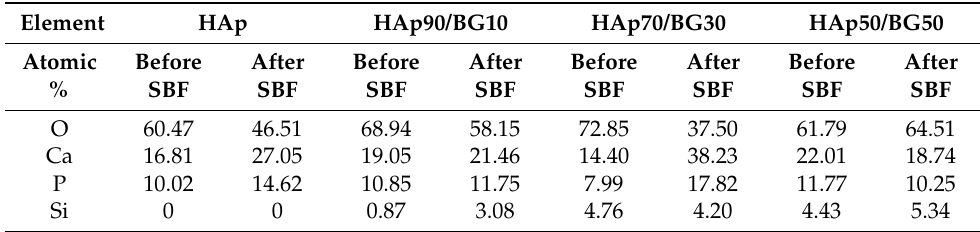
Table 6. Atomic composition of samples of HAp and HAp/BG composites before and after immersion in SBF solution, from EDX analysis (n =